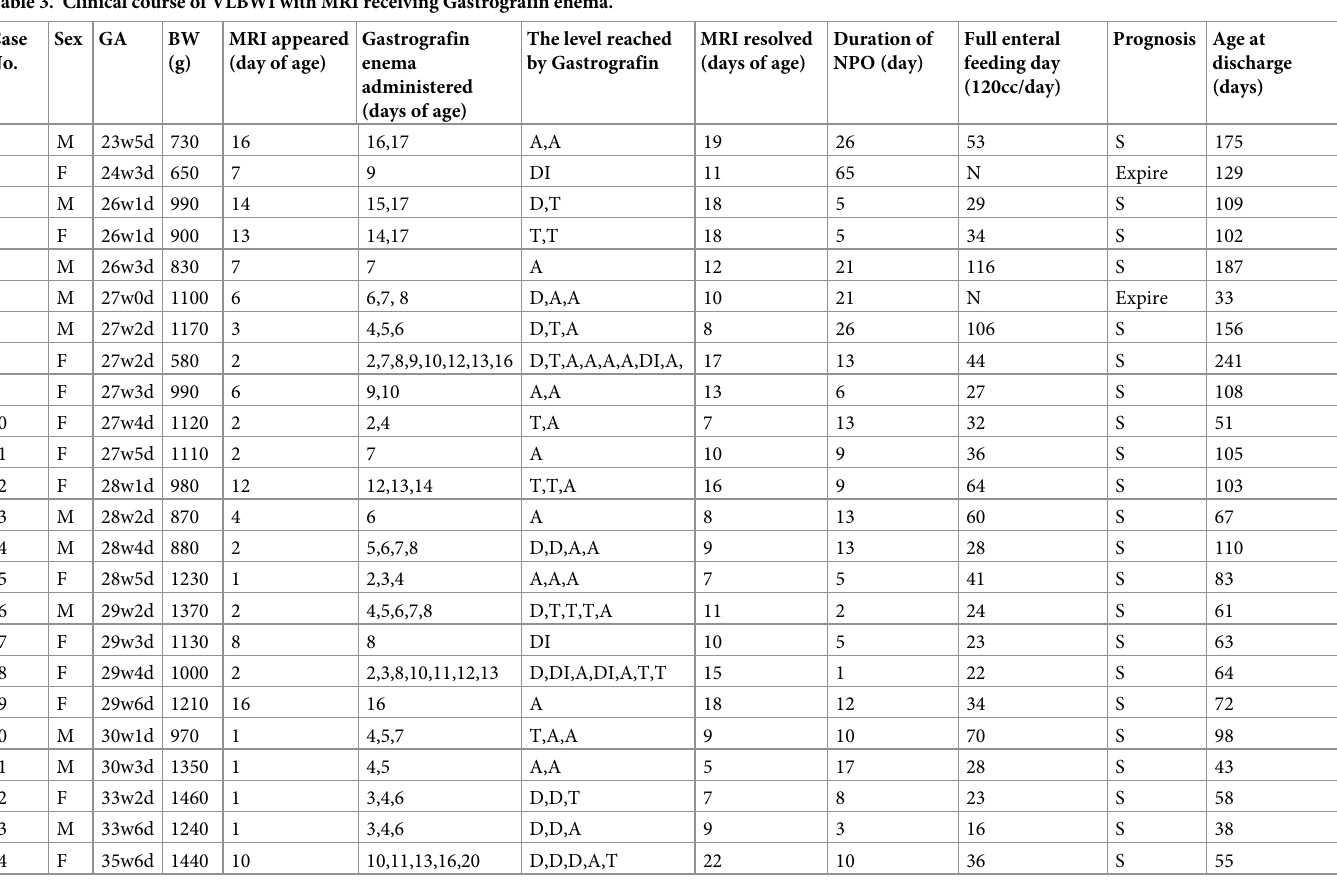
Table 3. Clinical course of VLBWI with MRI receiving Gastrografin